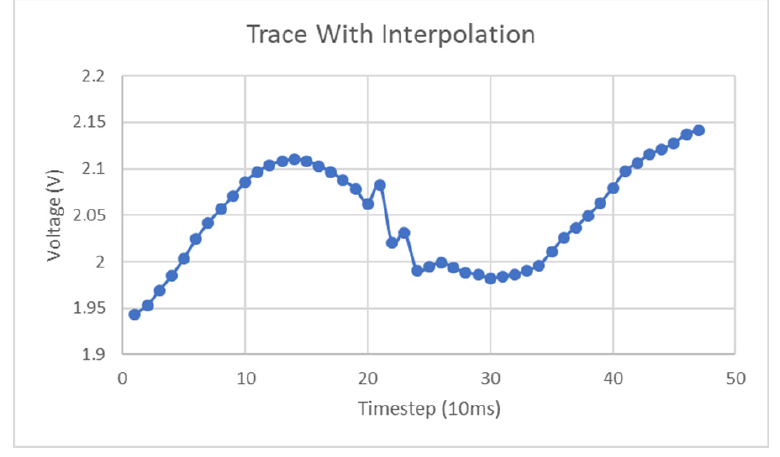
Figure 22. 3Hz interpolated lookup. Figure 22. 3 Hz interpolated lookup.